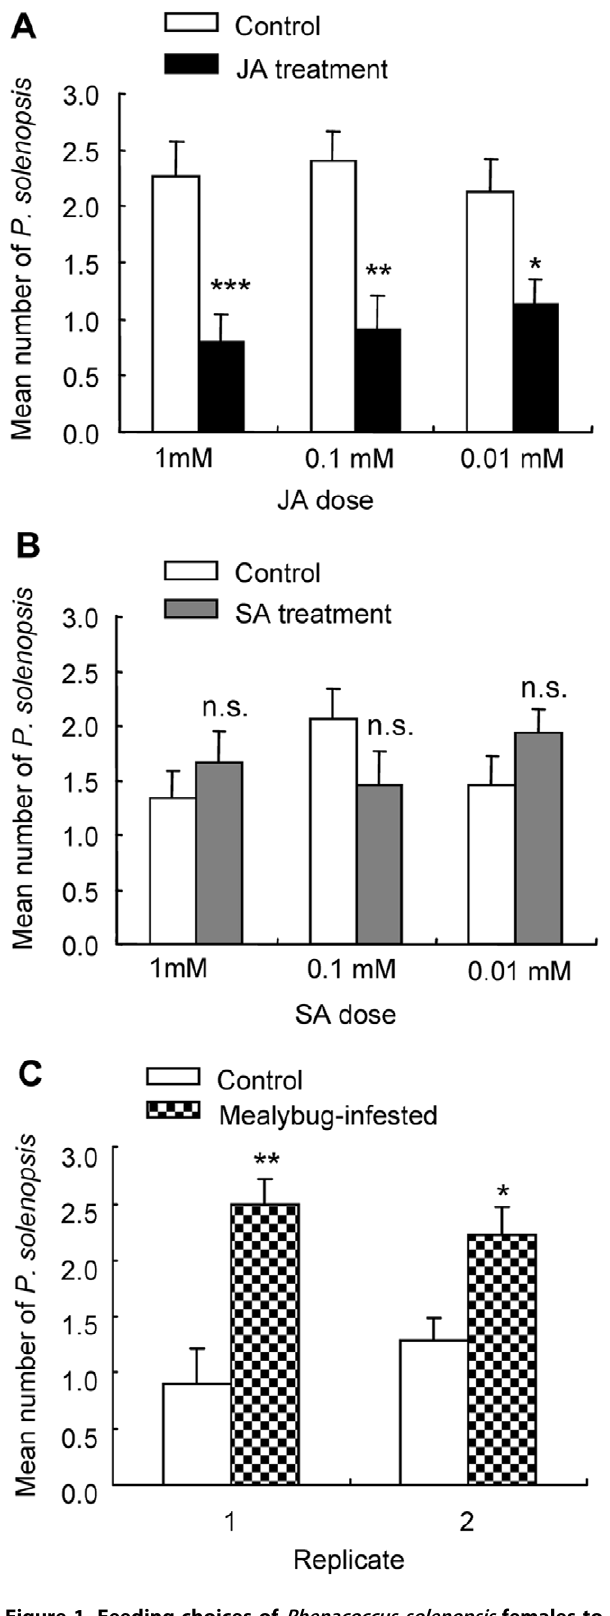
Figure 1. Feeding choices of Phenacoccussolenopsis females to JA-treated (A), SA-treated (B), or mealybug-infested leaves (C), when undamaged leaves (Control) were offered as alternative. Bars represent the mean number ( 6 SE) of mealybugs choosing